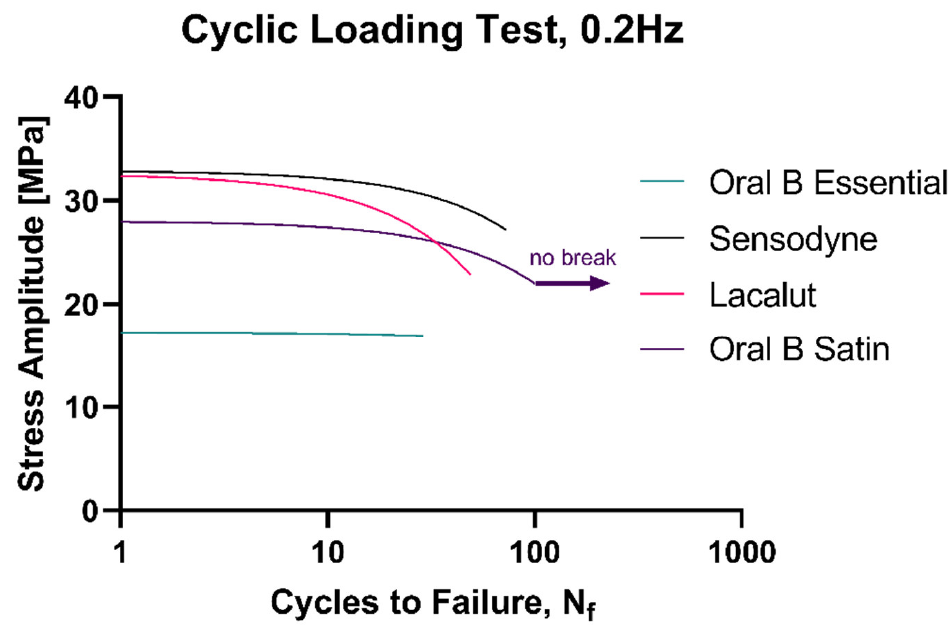
Figure 6. Cyclic loading response of the four studied flosses.